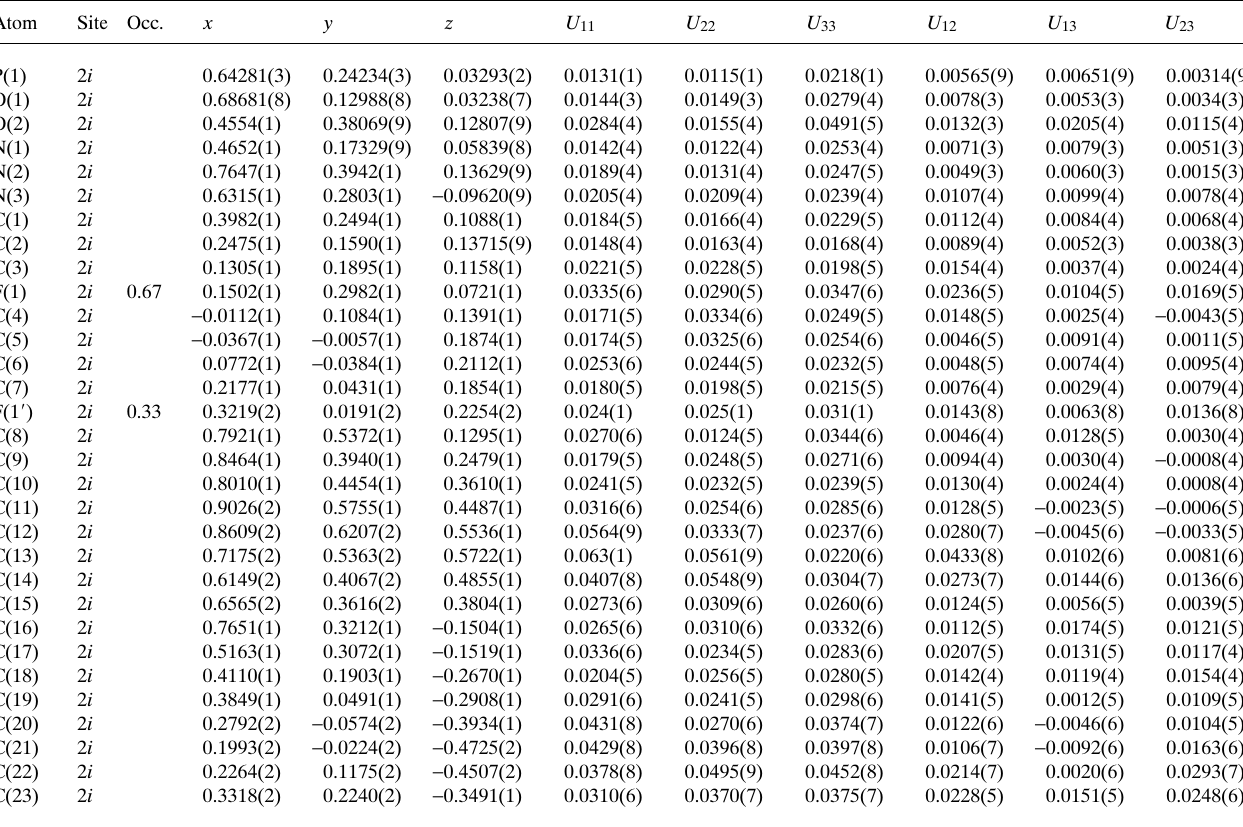
Table 3. Atomic coordinates and displacement parameters (in Å 2 ) .